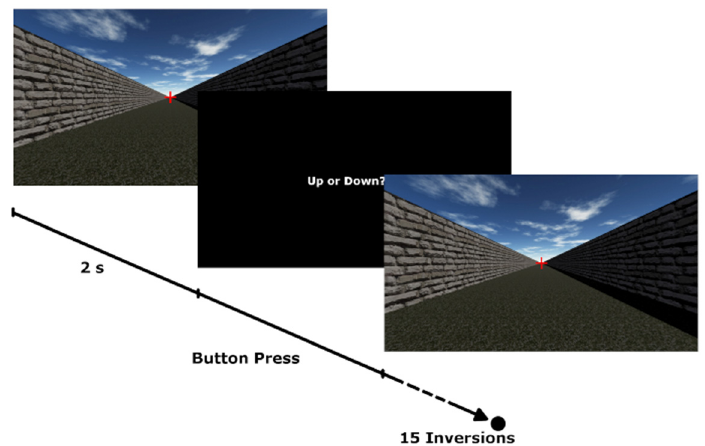
Figure 4. Experimental design.